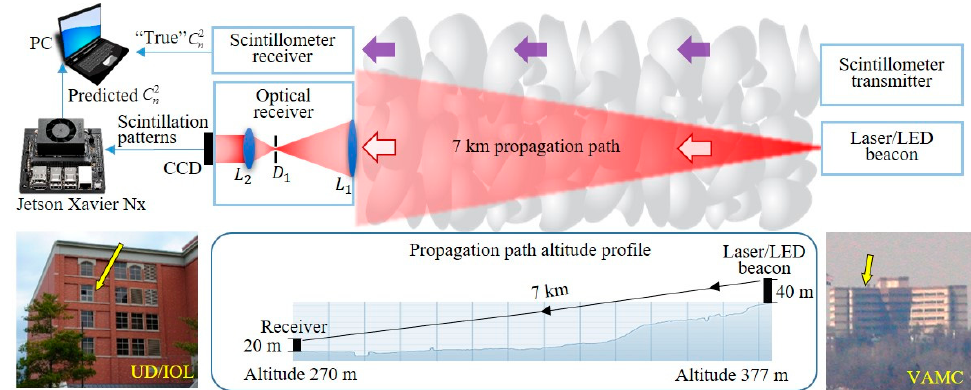
Figure 1. Schematic of the experimental setup used for TurbNet sensor development and evaluation.